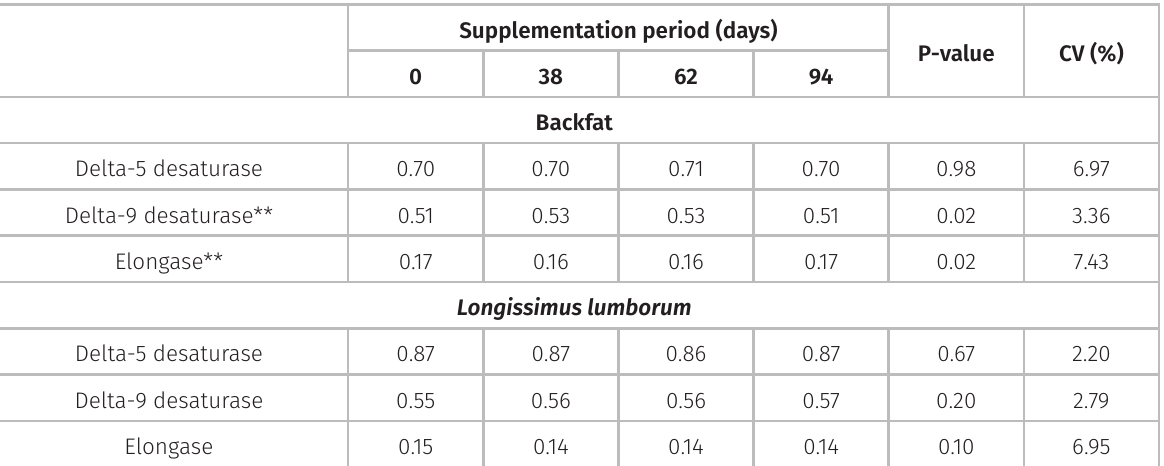
Table III. Activity of enzymes in the backfat and Longissimus lumborum of barrows fed with chromium yeast for different periods before the